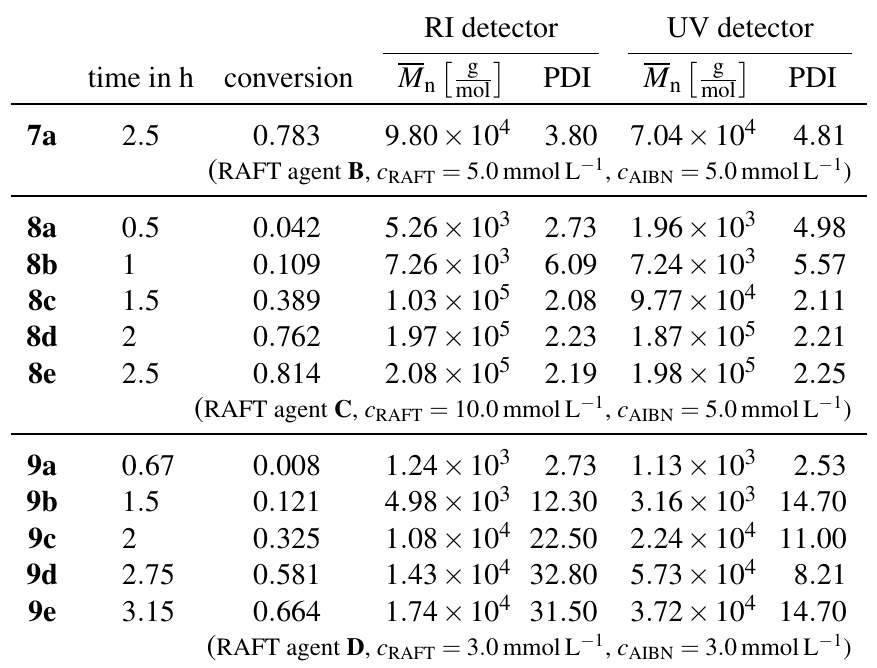
Table 3. Bulk polymerizations of n -butyl acrylate with different polyfunctional RAFT agents at 60 ◦ C and ambient pressure using AIBN as initiator. The table lists the individual experimental conditions, the gravimetrically determined monomer conversions of the samples, and the corresponding M and polydispersity indices (PDI) obtained by the RI and the n UV